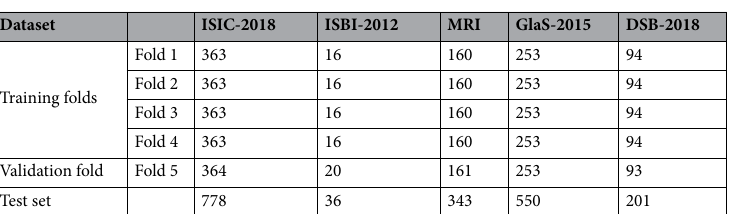
Figure 5. The differences in the architectures of the proposed MILDNet and the baseline approaches, including the classical U-Net, ResidualU-Net, ResDUnet, UNet + +, and MultiResUNet. For visual comparison, we have recreated the encoder, decoder, and skip connection structures of the baseline approaches following the network configuration represented in their original studies.